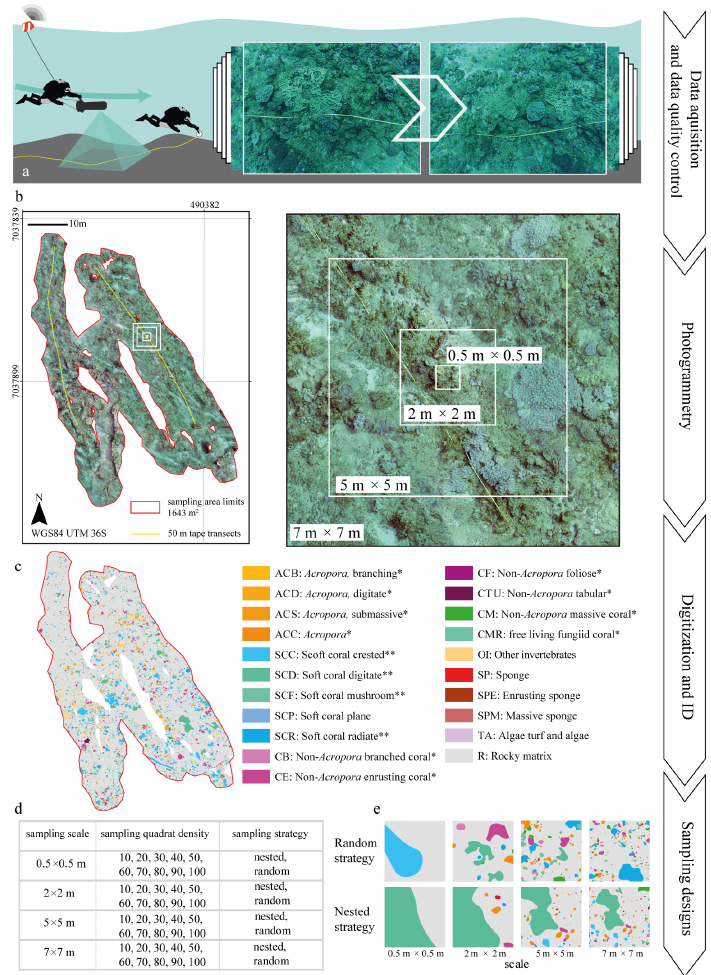
Figure 3. Schematic workflow overview for the field data collection and data analysis implemented: ( a ) transect deployment and image collection (left) and detailed example of the collected imagery (right); ( b ) processed orthoimage of the transects with the example of nested quadrats (left) and the detail of the nested sampling scales applied (right); ( c ) digitized output showing the abundance of different classes of benthic organisms; ( d ) summary of sampling scale, quadrat density and strategy applied; ( e ) graphical example of the digitized sessile organisms within different sampling scales. * and ** refer to the classification proposed by Edinger and Risk [60] and the classes used by Schleyer and Celliers [49], respectively. ID stands for Identification